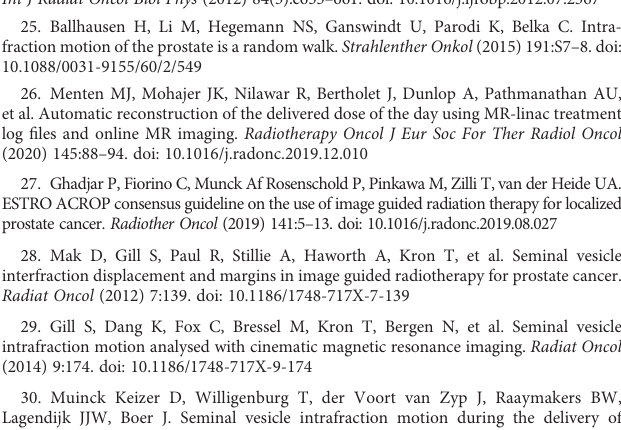
prescription dose (B) . Individual data points are shown as dots. The mean ± SD are shown as the error bars.